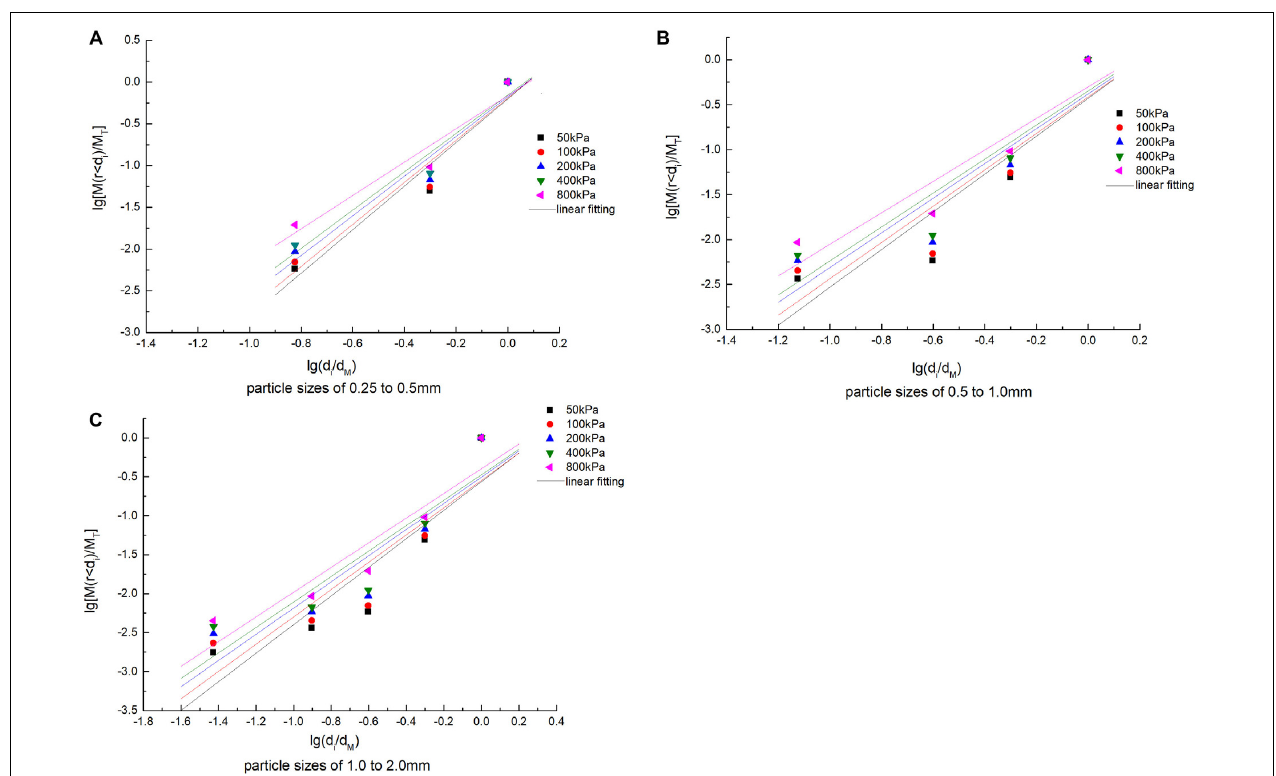
FIGURE 9 | Linear fitting for lg[M(r < d i )/M T ] and lg(d i /d M ). (A) Particle sizes of 0.25–0.5 mm, (B) particle sizes of 0.5–1.0 mm, and (C) particle sizes of 1.0–2.0 mm.